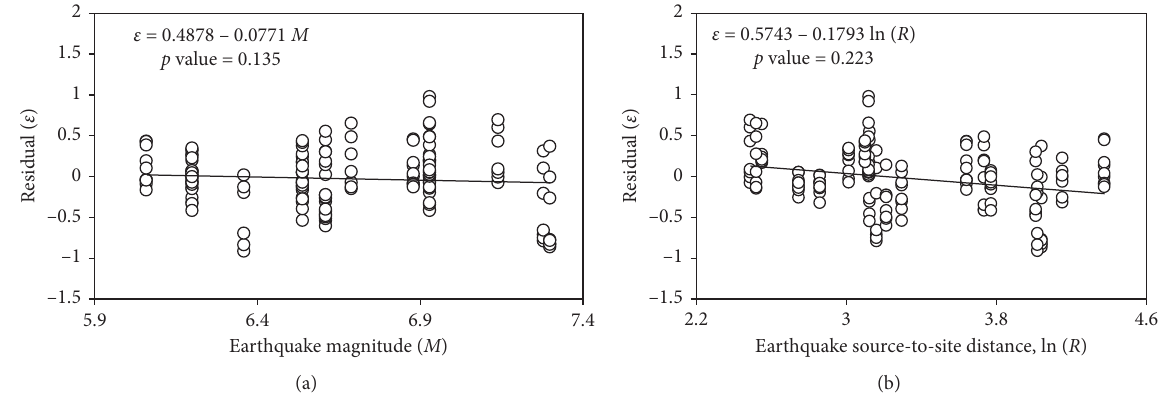
( 0 . 75 T − 3 . 5 T ) for the symmetric model with respect to (a) magnitude ( M ) and (b) distance ( R ). A 1 1